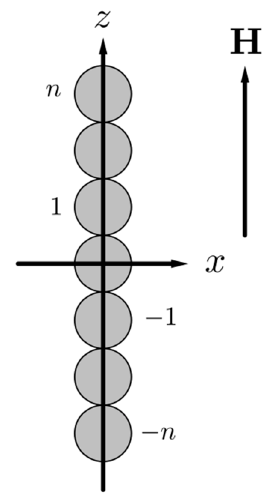
Figure 1. An illustration of the chain model and the used Cartesian coordinate system; n is the number of particles at the extremity of the chain, starting from the central one, which is number 0.